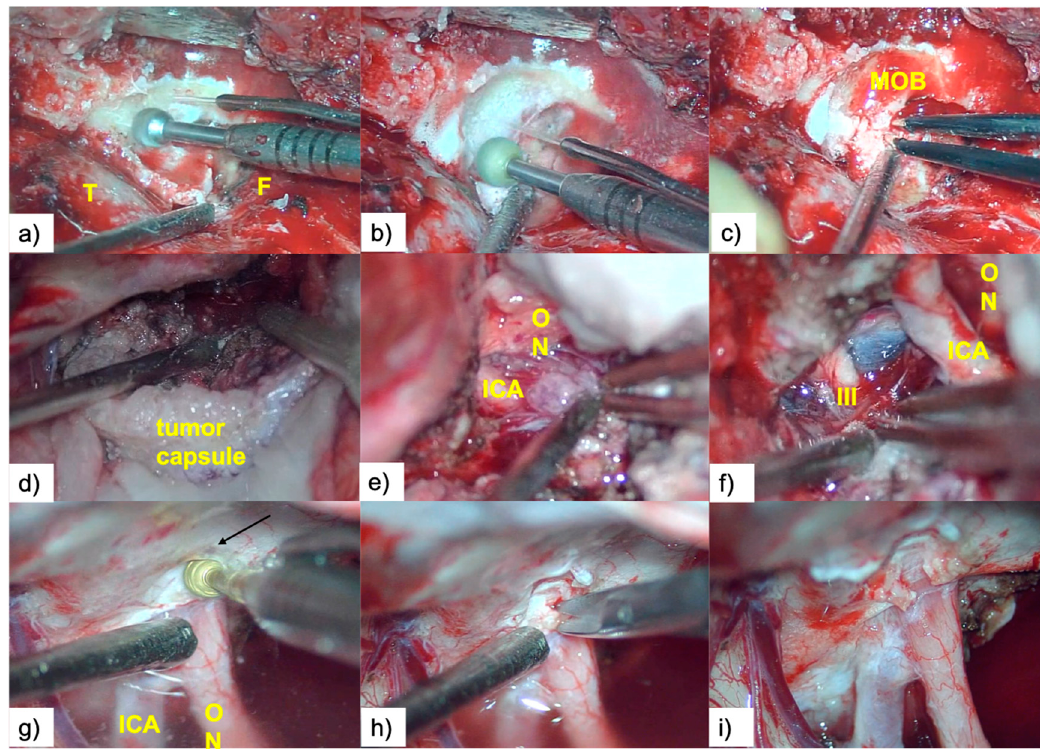
Figure 4. ( a , b ) Drilling the sphenoid ridge; ( c ) meningo-orbital band (MOB) was then coagulated and cut; ( d ) sphenoid wing meningioma (SWM) dissection using the dynamic retraction technique. We